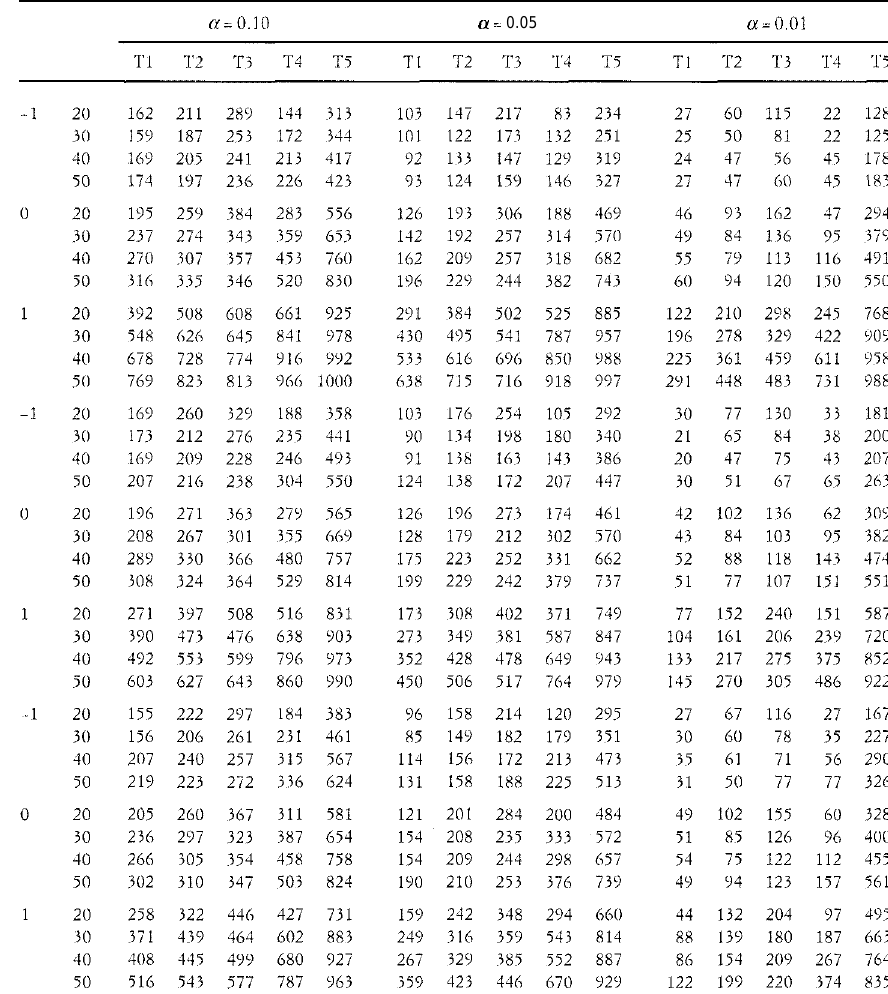
Simulated rejection power (twltiplietl by 1,000) ofgoodness-oJ-fit teslsfor